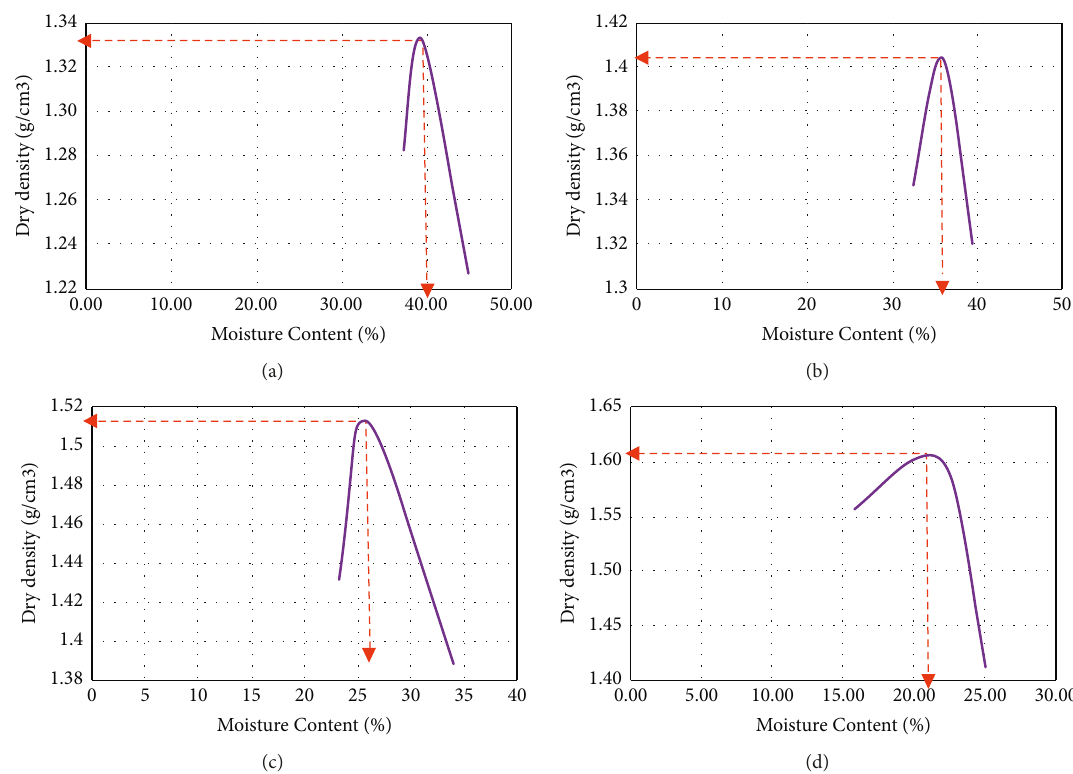
Figure 5: Density-moisture content relationship for untreated and treated soil samples. (a) Natural compaction, (b) 5% stabilization, (c) 15% stabilization, and (d) 25%